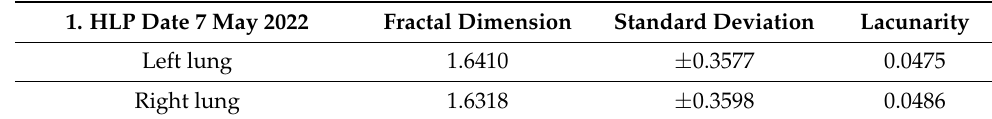
Table 7. Calculation of fractal indicators for the healthy lung patient